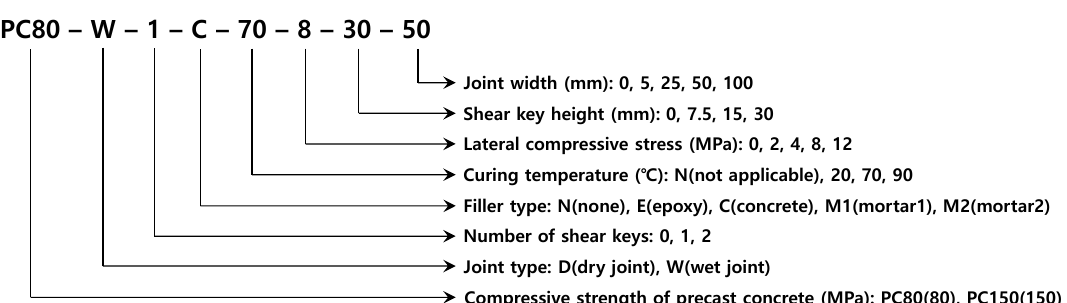
Table 3. Variables of push-off test ( c f ′ = 150 MPa). Joint Type